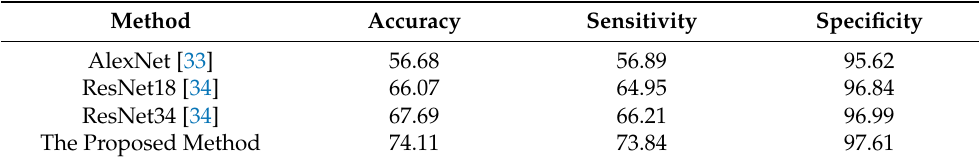
Table 3. Results of proposed method and other